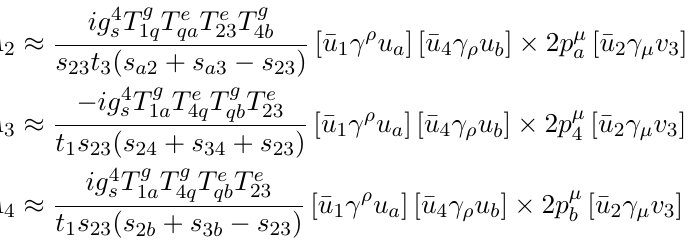
and p come from /p 2 3